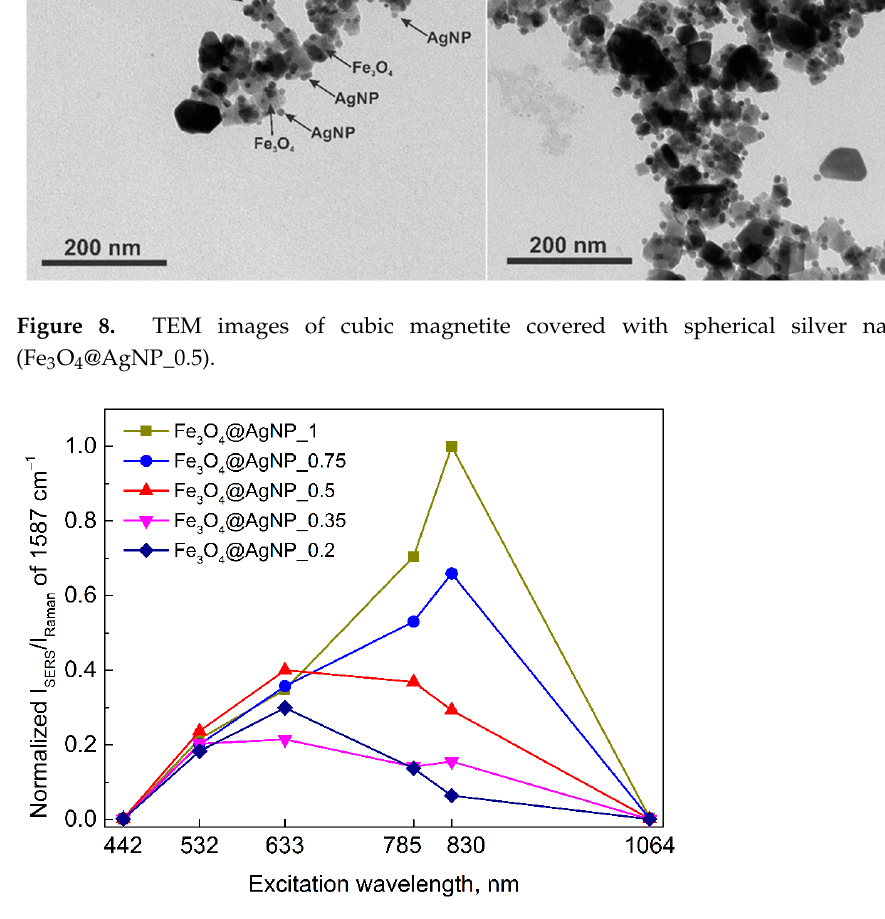
exactions from 442 to 830 nm. The procedure to find EFs is detailed elsewhere [79].